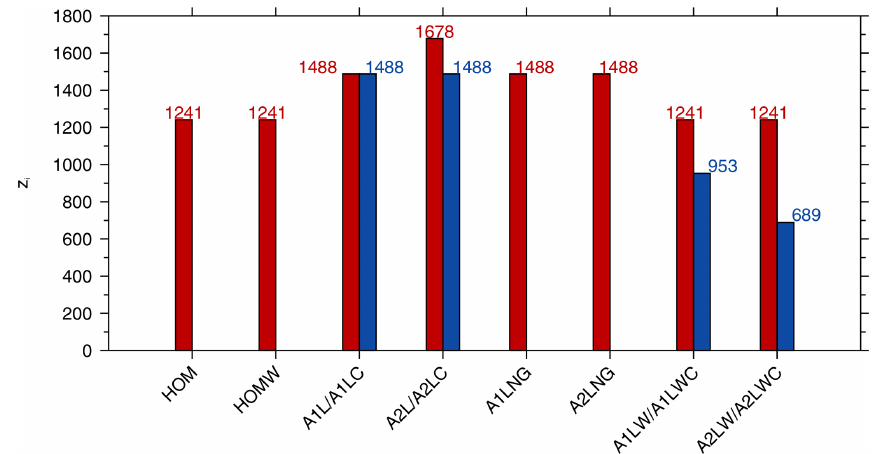
Figure 5. Bar chart of the CBL height for each run marked with a concrete value. The red bars from left to right represent runs HOM, HOMW, A1L, A2L, A1LNG, A2LNG, A1LW, and A2LW. The blue bars from left to right represent runs A1LC, A2LC, A1LWC, and